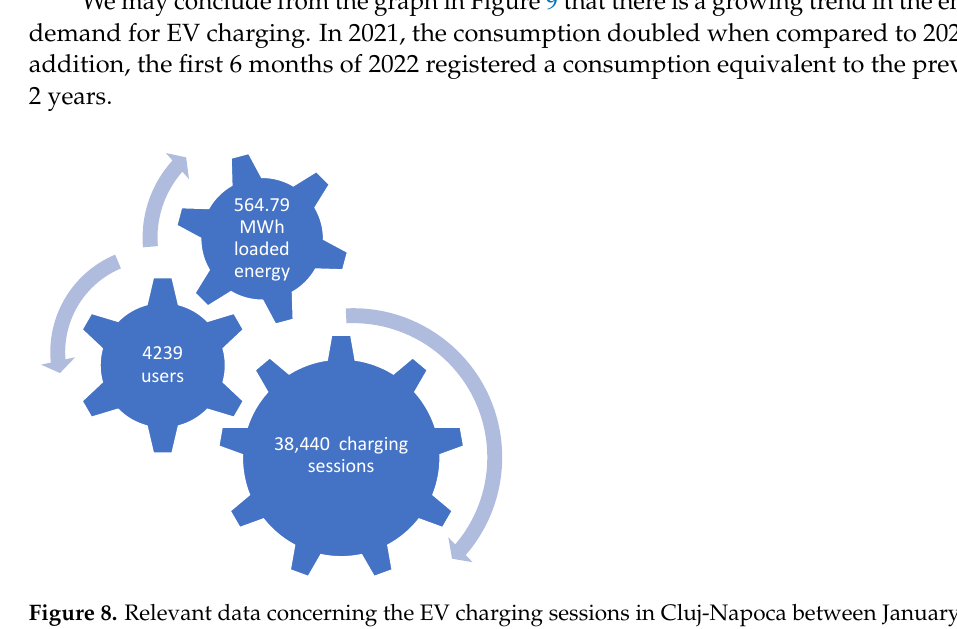
Figure 9. Variation of yearly energy consumption at EV charging stations in Cluj - Napoca. 4. Discussion Our case study focused on the Unirii Square Charging station from January 2019 to June 2022. During this period, there was 76.2 2 M Wh consumed in 3225 h; the station was used without charging for 26 h , it was out of order for 6 h , and it was free for 88 , 254 h , as seen in Figure 10. The number of hours and the energy quantity represent the sum of the three available sockets. The consumption and the used period for every socket can be observed in detail, in Figure 11. Socket 1 uses the CHAdeMO standard. It charged 8.32 MWh in 940 h. The socket was busy but without charging for 26 h and it was free for 29,537 h. Socket 2 uses Type 2 stand- ard. It charged 7.62 MWh in 284 h. The socket was busy but without charging for 0 h and it was free for 30,219 h. Socket 3 uses the CCS standard. It charged 60.27 MWh in 2000 h. The socket was busy but without charging for 21 min and it was free for 28,503 h. For this charging station, the most used socket was the one that uses the CCS standard for fast charging. It can be seen that the charging station worked under optimal conditions. It was out of order for 6 h, which represents less than 1% of the total monitored time. Even though the station was used daily, we see that it was actually used under 5% of the time, with over 95% of the analyzed period being unoccupied. The charging station is situated in the central area and the parking cost was around 1.6 EUR/hour.